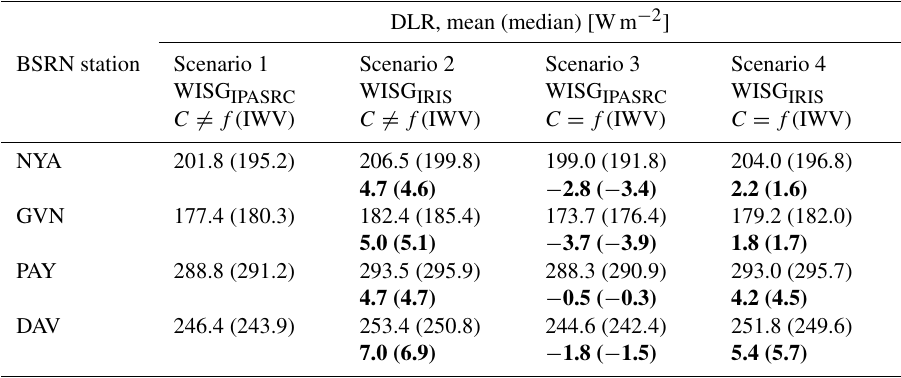
Table 5. Same as Table 4 except for the 2006–2015 clear-sky DLR time